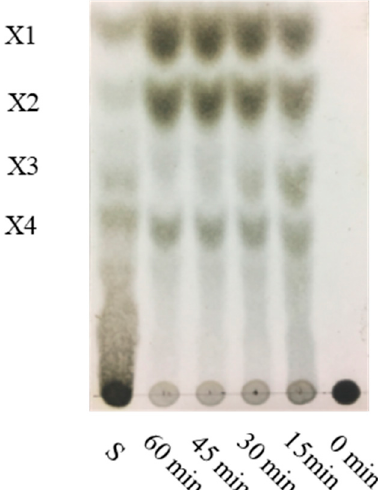
Figure 8. Hydrolysis of β -1,3-xylan by the rXyl88 with different hydrolysis time. Lane S, markers: X1 xylose, X2 β -1,3-xylobiose, X3 β -1,3-xylotriose, X4 β -1,3-xylotetraose, obtained by hydrolysis of β -1,3-xylan by TFA.